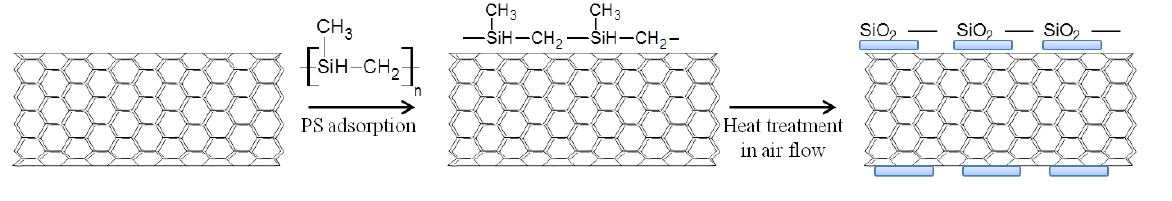
-CNT) preparation x